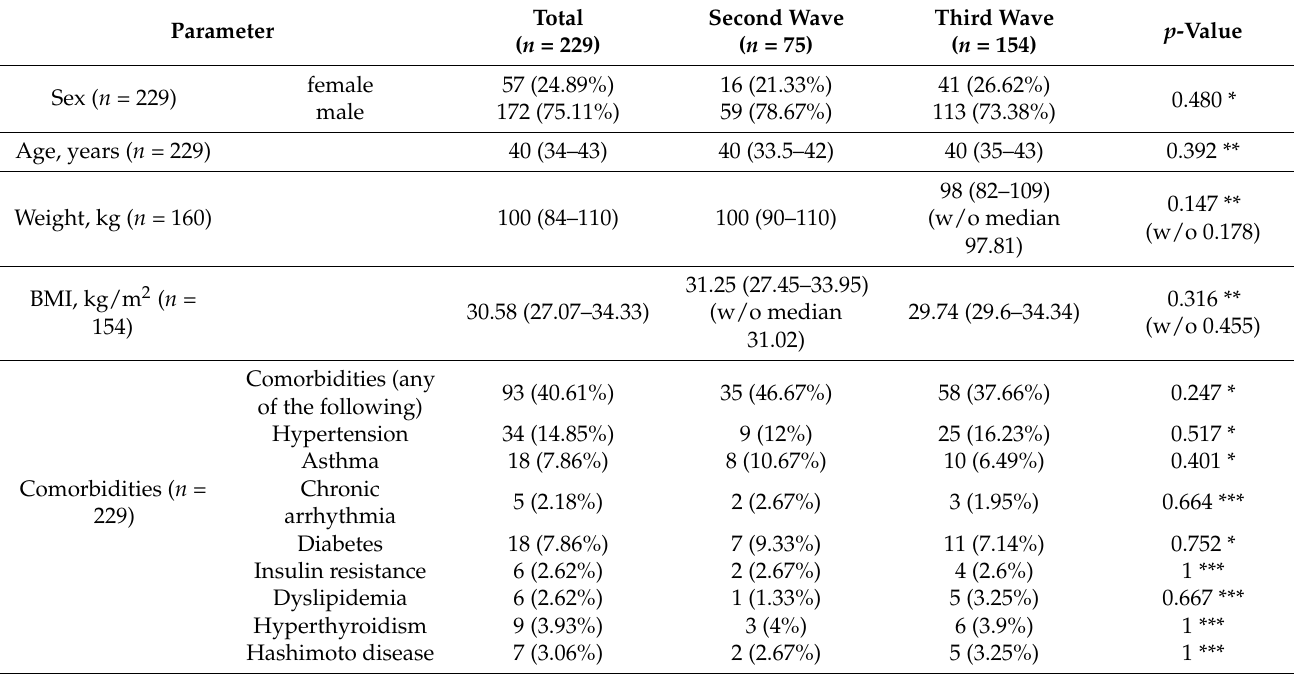
Table 1. Comparison of general patients’ characteristics between the second and the third wave.